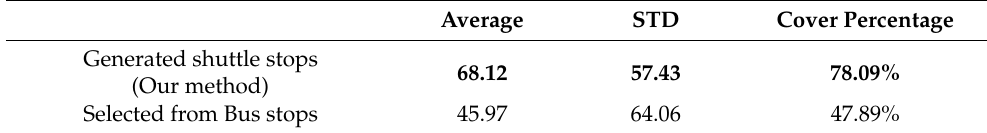
Table 3. Comparing the service capability of the generated shuttle stops with the existing bus